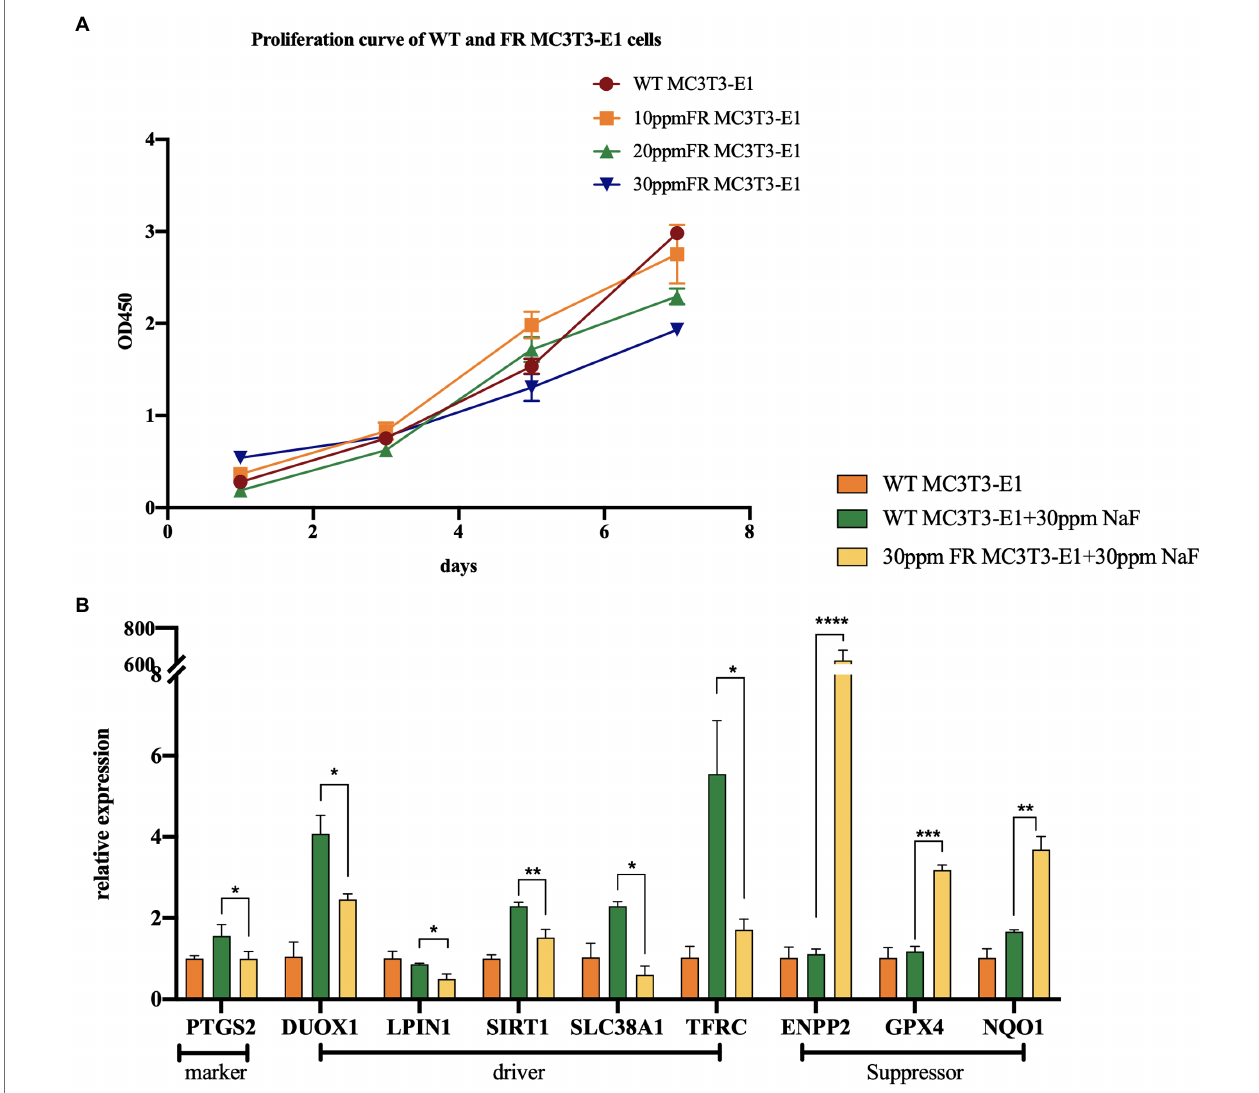
FIGURE 2 | The changes of ferroptosis-related gene expression in fluoride-resistant MC3T3-E1 cells. (A) Cell-Counting-Kit-8 assay was used to determine the cell proliferation rate. Fluoride-resistant MC3T3-E1 (FR MC3T3-E1) cells, were inducted by sub-cultivating in 10 ppm fluoride concentration gradient ascending media, and continued till the proliferation rate of the cells in the fluoride media became normal. (B) Real-time PCR showed the changes of ferroptosis-related gene expression between 30 ppm FR MC3T3-E1 cells and WT MC3T3-E1 cells. When cultured in 30 ppm fluoride medium, the expression of Prostaglandin-Endoperoxide Synthase 2 (PTGS2) in FR cells was lower than that in WT cells, which is the marker of ferroptosis. Dual Oxidase 1 (DUOX1), Lipin 1 (LIPIN1), Sirtuin 1 (SIRT1), Solute Carrier Family 38 Member 1 (SCL38A1), and Transferrin Receptor (TFRC) are the drivers of ferroptosis. Ectonucleotide Pyrophosphatase/Phosphodiesterase 2 (ENPP2), GPX4, NAD(P)H Quinone Dehydrogenase 1 (NQO1) are ferroptosis suppressors. The result indicates that the expression of ferroptosis driver in FR cells is lower than that in WT cells. Similarly, the expression of ferroptosis suppressor in FR cells was significantly higher than that in WT cells. * p < 0.05; ** p < 0.01; *** p < 0.001 and **** p <